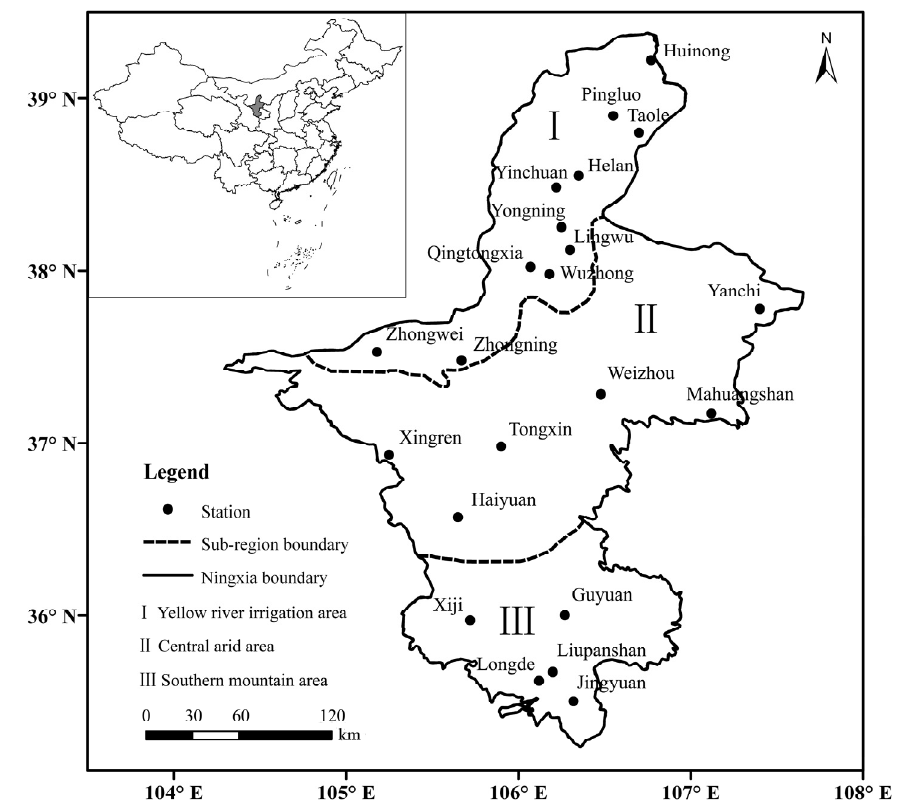
Figure 1. Location of study area and distribution of meteorological